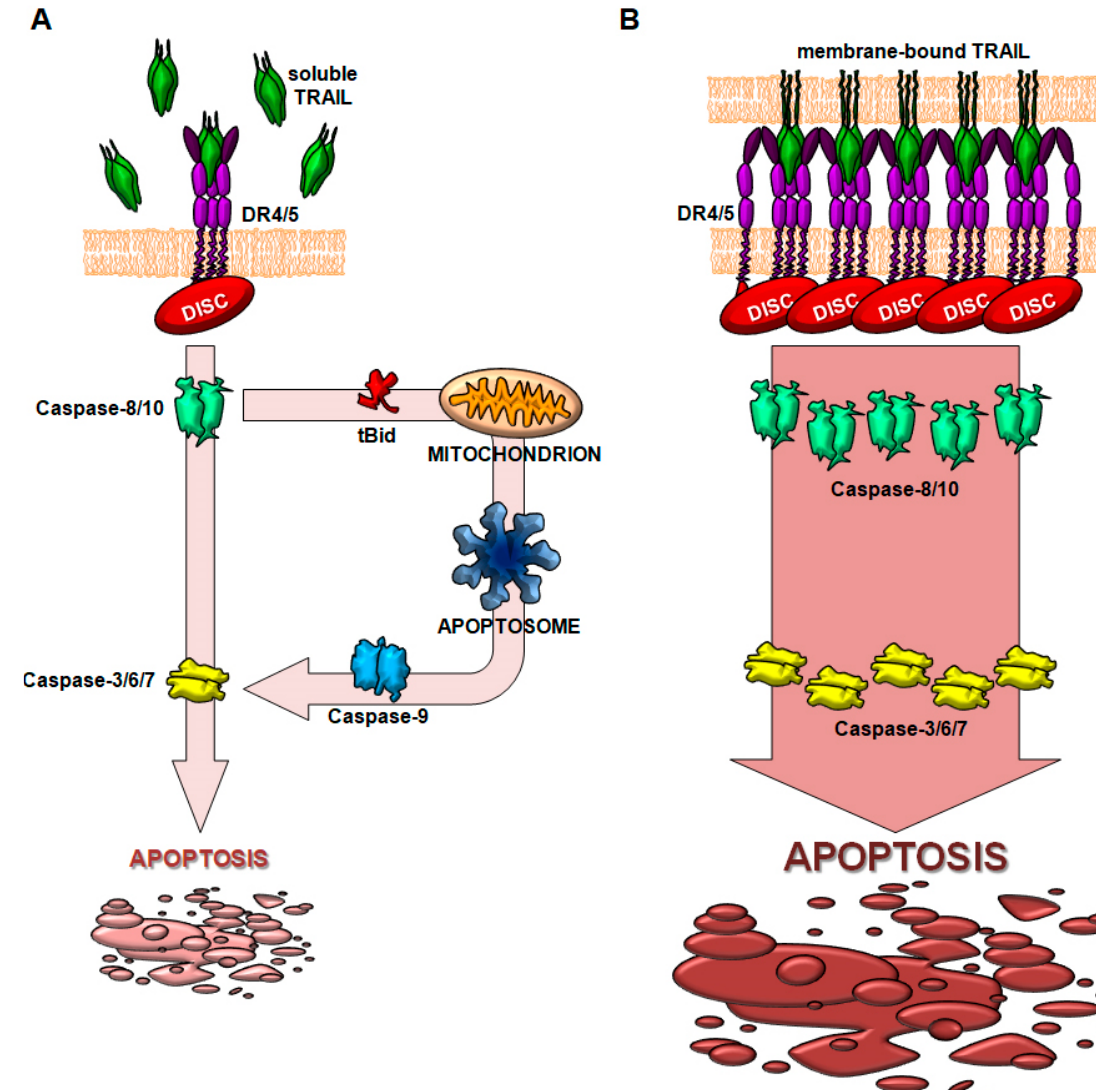
Figure 4. Proposed model for the increase of bioactivity of membrane-bound TRAIL. ( A ) In the case of soluble TRAIL, death receptors (DRs) trimerize and promote the sequential recruitment of FADD and of caspase-8, forming the death-inducing signaling complex (DISC). Caspase-8 processing is enough to trigger apoptosis, but the mitochondrial pathway (through Bid processing) is needed to induce enough caspase-3 activation. ( B ) When TRAIL is present as a membrane-bound protein, TRAIL trimers on the membrane surface induce receptor clusterization and the subsequent enhanced DISC recruitment. Consequently, a high amount of caspase-8 is processed, being enough to directly induce caspase-3 activation.